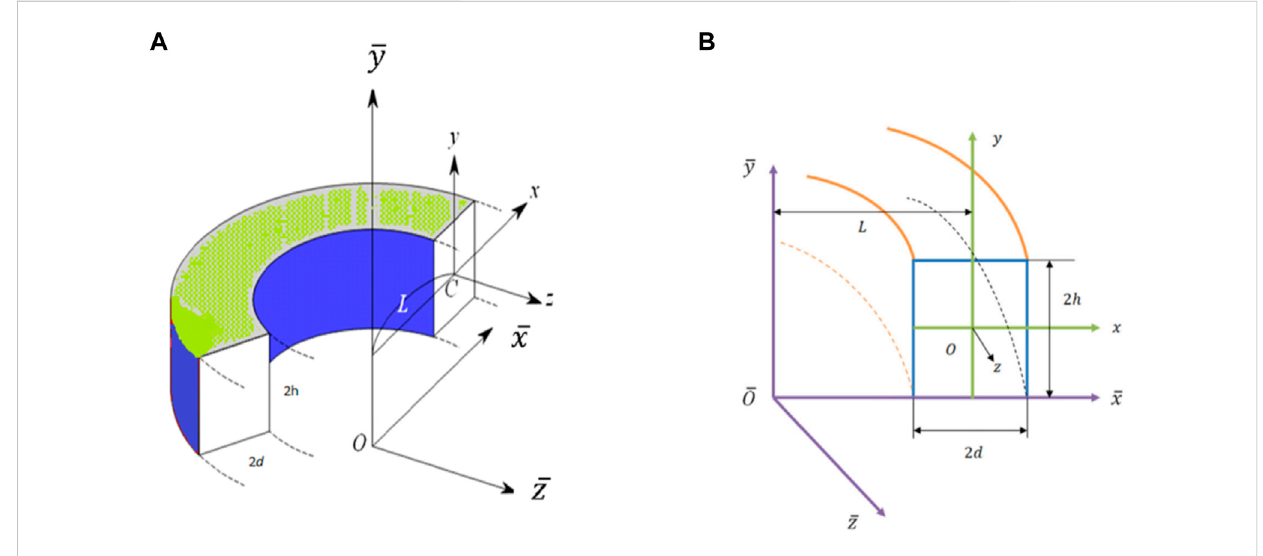
FIGURE 1 Geometrical view of the curved